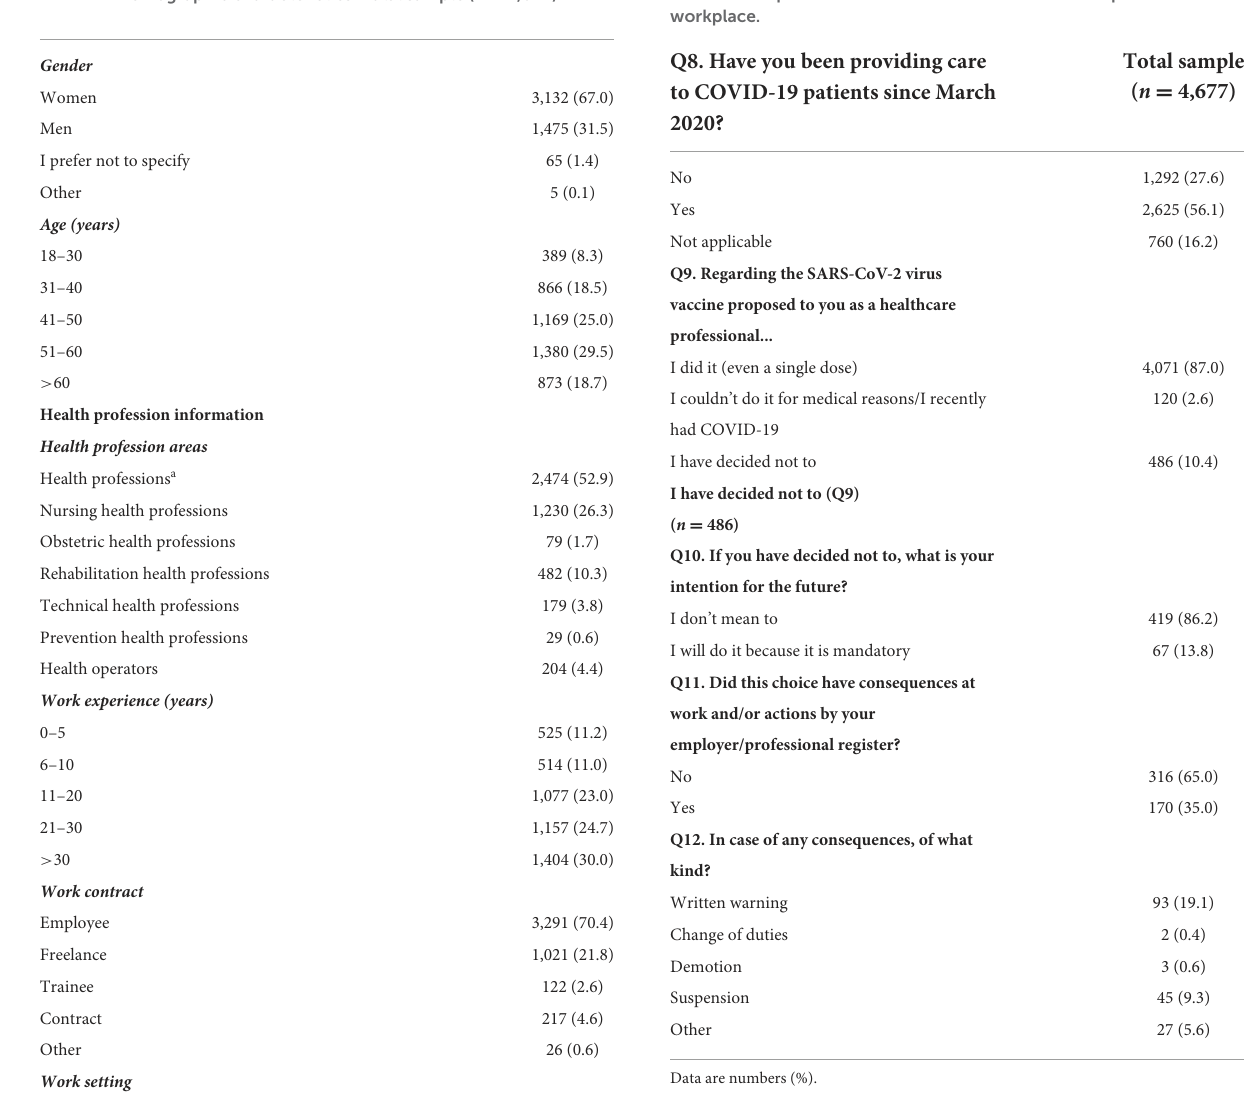
TABLE 1 Demographic characteristics. Total sample ( n = 4,677). TABLE 2 Responses on vaccine adherence and consequences at the